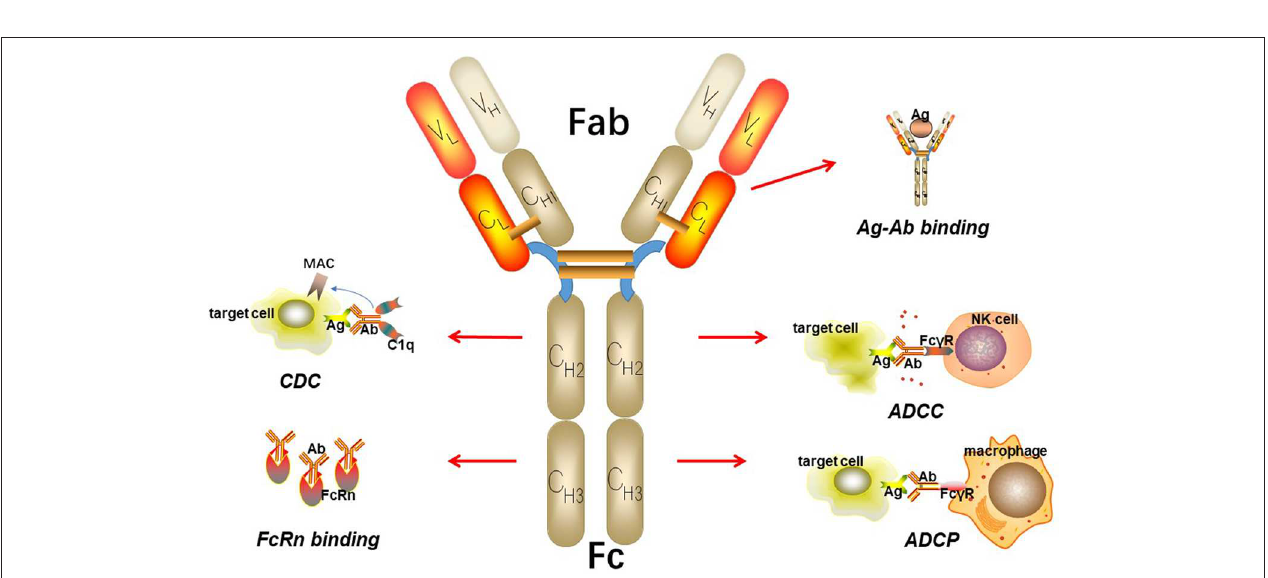
FIGURE 2 | The basic structure of IgG. IgG can be divided into two parts including Fab fragment and Fc fragment. Fab fragment plays an important role in antigen recognition and binding while Fc fragment can mediate ADCC, CDC, and ADCP. Besides, Fc fragment can bind to FcRn to protect itself from elimination.